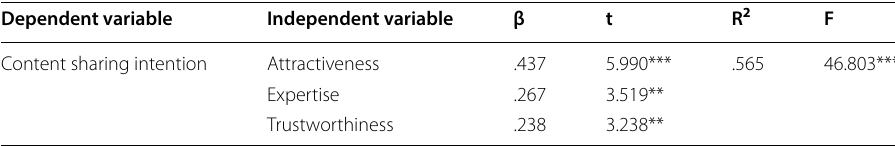
Table 11 Multiple regression result of vlogger’s attributes on content sharing intention— explicit exposure type